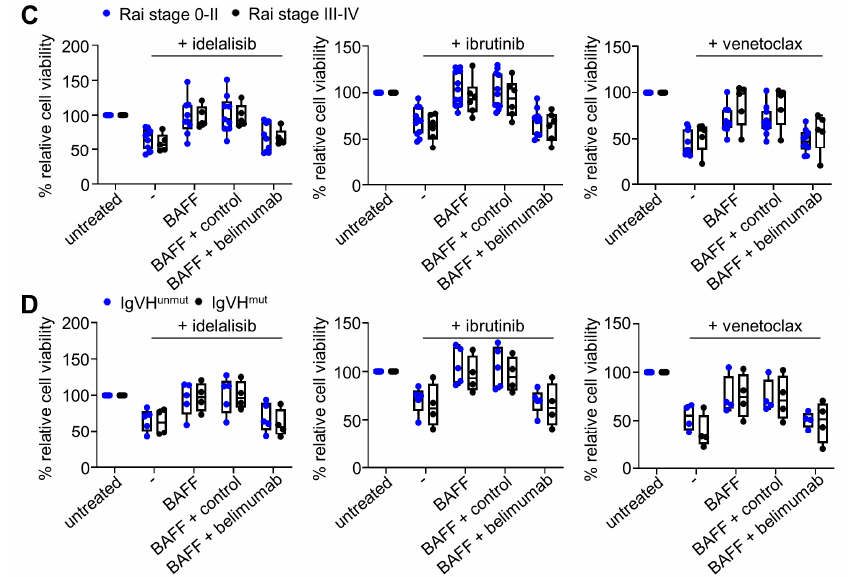
Figure 3. Neutralization of BAFF by belimumab sensitizes CLL cells to small molecule inhibitor treatment. ( A ) Cell viability of PBMC from CLL patients (n = as indicated) was determined using CTG assays after exposure to idelalisib (500 nM), ibrutinib (500 nM) or venetoclax (2 nM) in the presence or absence of rhBAFF (500 ng/mL), belimumab or control antibody (10 µg/mL each). Results were normalized to the respective untreated samples and relative viability was calculated. ( B – D ) Data sets depict effects according to clinical Binet stage ( B ), Rai stage ( C ) and IgVH mutational status ( D ). For statistical analyses, a RM one-way ANOVA with Tukey’s multiple comparisons test was performed in ( A ) for data sets of idelalisib, ibrutinib and venetoclax. In ( B ), for idelalisib, ibrutinib and venetoclax